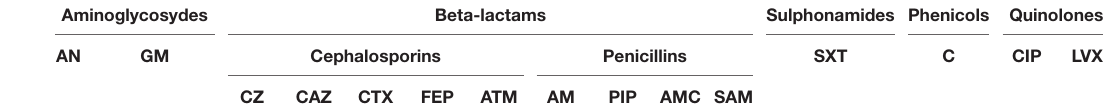
TABLE 6 | Association between antibiotic resistance phenotypes of E. coli isolates from drinking water